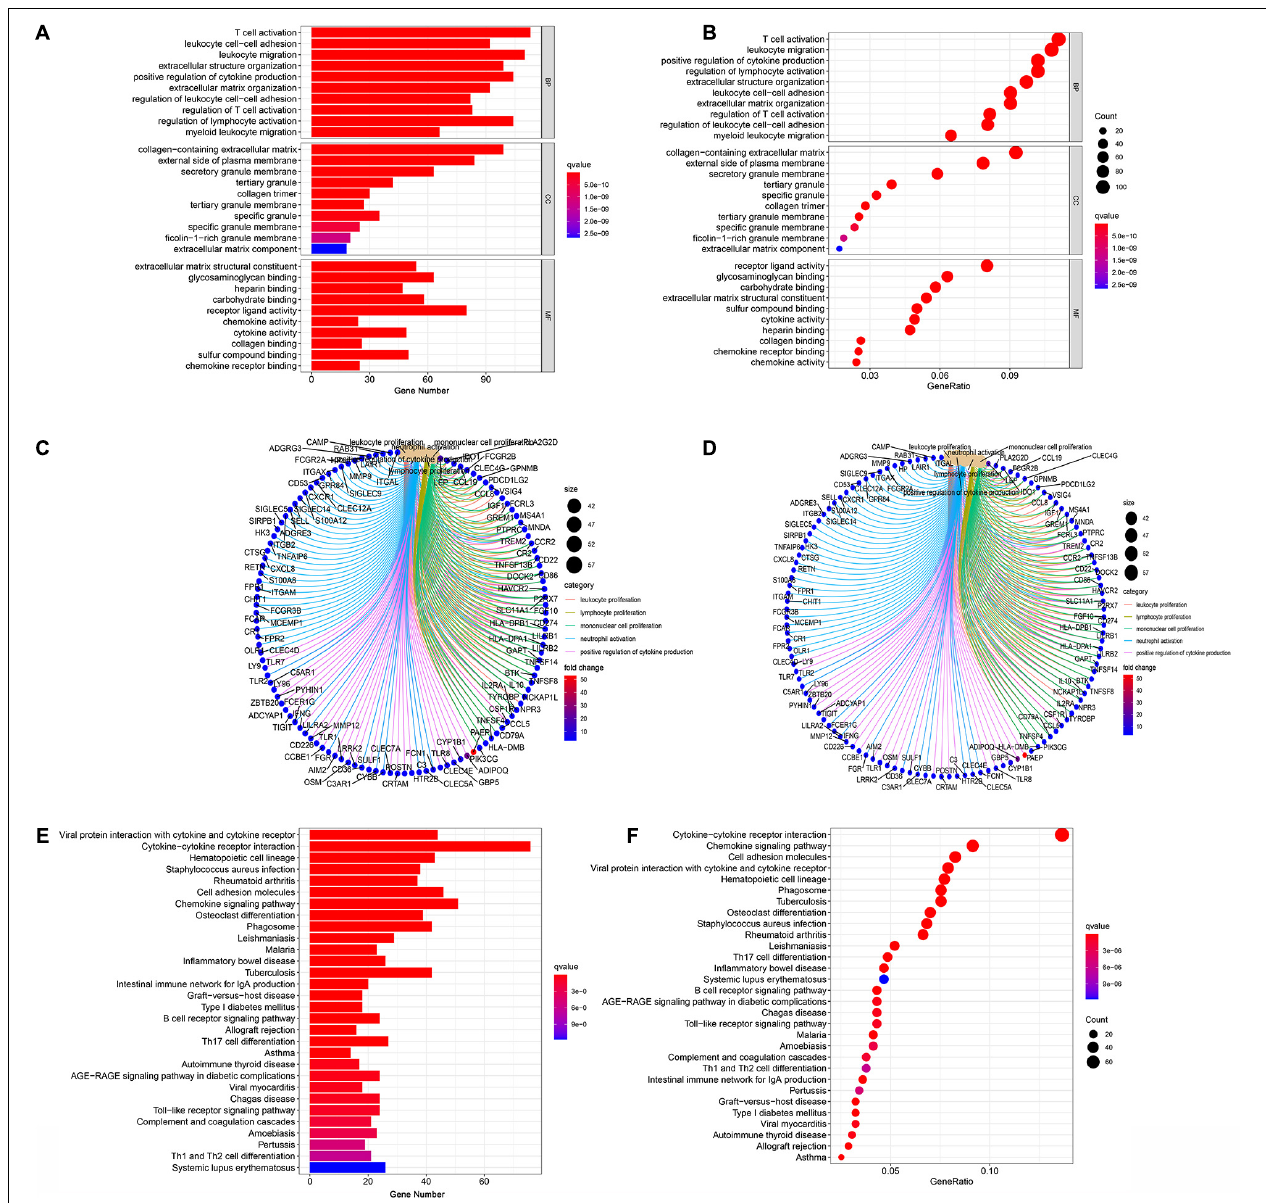
FIGURE 3 | Enrichment analysis GO and KEGG for 1,110 DEGs. (A–C) GO enrichment analysis for 1,110 DEGs, p < 0.05 was considered to be enriched significantly. (D–F) KEGG enrichment analysis for 1,110 DEGs, p < 0.05 was considered to be enriched